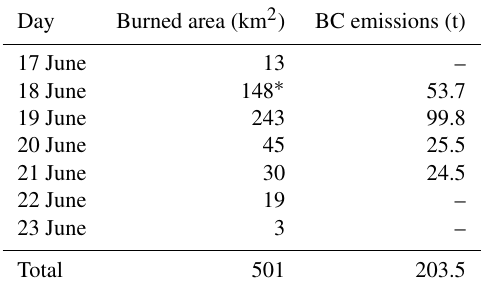
Table 3. Burned area and BC emissions per day for the June 2017 forest fire in Portugal ( ∗ cloud